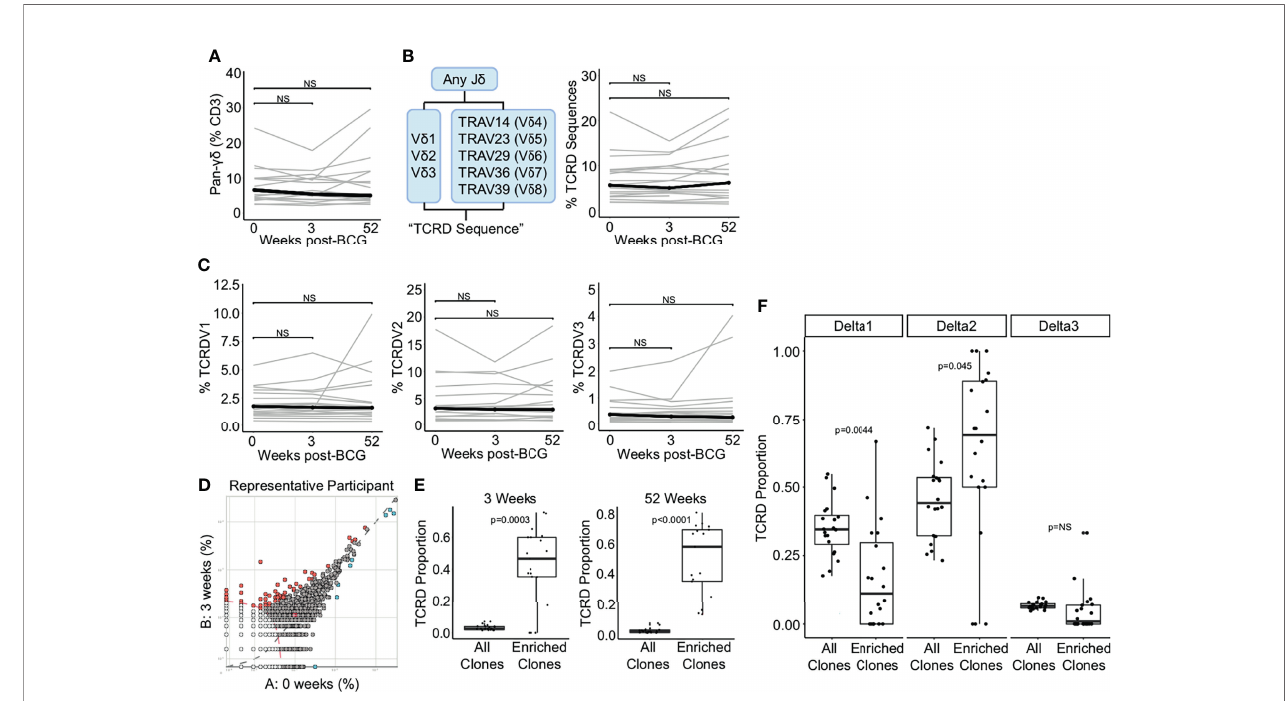
FIGURE 3 | TCR- d clonotypes are durably expanded after BCG revaccination. (A) A pan- gd antibody (clone 11F2) was used to quantify changes in the frequency of gd T cells following BCG revaccination. Percentage of gd T cells in PBMC isolated 0 weeks, 3 weeks, and 52 weeks post-revaccination. Percentages are expressed as a percent of CD3 positive cells in each sample. Connected lines depict the percentage of gd T cells from each participant at each time point (grey). The median percentage from each time point is shown (black). (B) gd TCRs were quanti fi ed as the percent of templates that contain a TRDJ and TRDV1, TRDV2, TRDV3, TRAV14 (TRVD4), TRAV23 (TRDV5), TRAV29 (TRDV6), TRAV36 (TRDV7), or TRAV39 (TRDV8). This is expressed as a percent of total templates. (C) Percent of templates that contain TRDV1 (left), TRDV2 (center), or TRDV3 (right) expressed as a percent of total templates at each time point. (D) The differential abundance tool (ImmunoSEQ analyzer) was used to identify clones that are expanded post-BCG revaccination. Scatter plot visualizes the frequency of clones at the 0 week time point (x-axis) and 3 weeks post-BCG (y-axis) from one representative participant. Each dot represents one clone. Red dots are statistically enriched at 3 weeks, and blue dots are statistically enriched at the 0 week time point (Binomial test with Benjamini-Hochberg correction for multiple hypothesis testing, n = 130,727 clones). (E) Proportion of expanded clones that express TCR- d compared to the proportion of all clones that express TCR- d at 3 weeks (left) and 52 weeks post-BCG (right). Each dot represents one participant (Wilcoxon signed-rank test, n = 18, p = 0.0003 and p < 0.0001, respectively). (F) Proportion of expanded TCR- d clones that contain TCRDV1 (left), TCRDV2, (center), or TCRDV3 (right) compared to the proportion of all TCR- d clones at 3 weeks post BCG that contain each respective TCRDV gene. Each dot represents one participant (p = 0.004, 0.045, and 0.079, respectively, n = 18). Unless stated otherwise, statistical testing was performed using the Wilcoxon signed-rank test with Benjamini-Hochberg correction for multiple hypothesis testing, and adjusted p-values are reported. NS, Not Signi fi